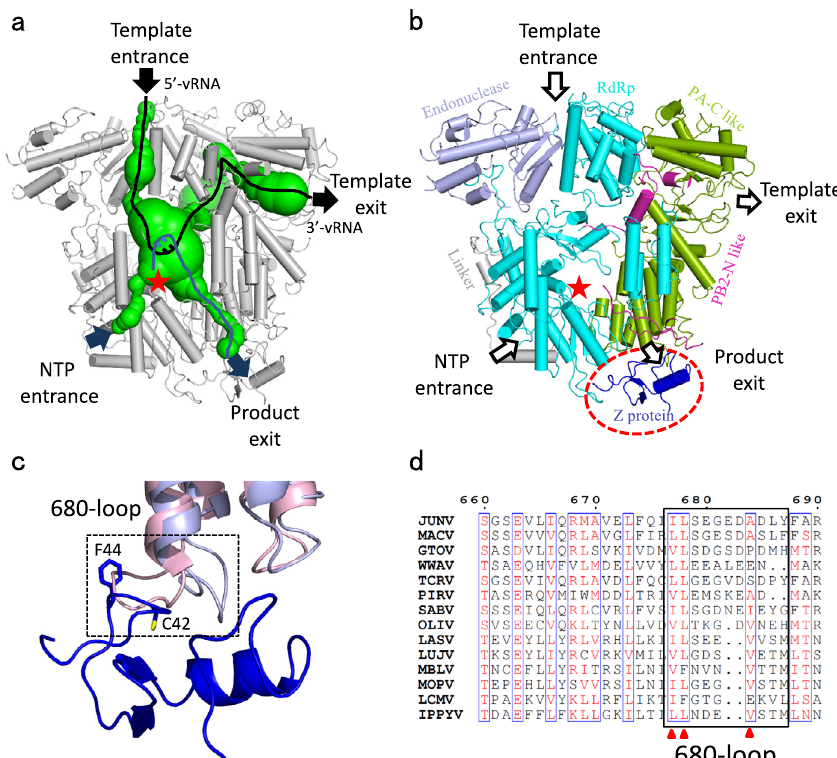
Fig. 5 Schematic diagram showing features of JUNV L protein for RNA synthesis. a Tunnels within the JUNV L structure for RNA synthesis. The template entrance and exit (black), the NTP entrance and product exit (blue) are shown. The catalytic site is indicated by a red star. b The product exit is blocked by Z protein. The protein structures are shown as cartoon and colored by domains, the catalytic site is indicated by a red star. The template entrance, NTP entrance, template exit and product exit are indicated by arrows. c Comparison of the 680-loop of MACV L protein and JUNV L – Z complex. Superimposition of the apo MACV L protein on the JUNV L – Z complex. The black dot box indicates magni fi ed views of the 680 loops of the JUNV L protein (shown in light purple) or MACV L protein (shown in light pink), and displays the steric hindrance between MACV L and JUNV Z protein (shown in blue). d Sequence alignment of the region around the 680-loop. The conserved residues were indicated by red triangles. GTOV, Guanarito virus; WWAV, Whitewater Arroyo virus; PIRV, Pirital virus; SABV, Sabia virus; OLIV, Oliveros virus; LUJV, Lujo virus; MBLV, Mobala virus; MOPV, Mopeia virus; LCMV, lymphocytic choriomeningitis virus; IPPYV, Ippy